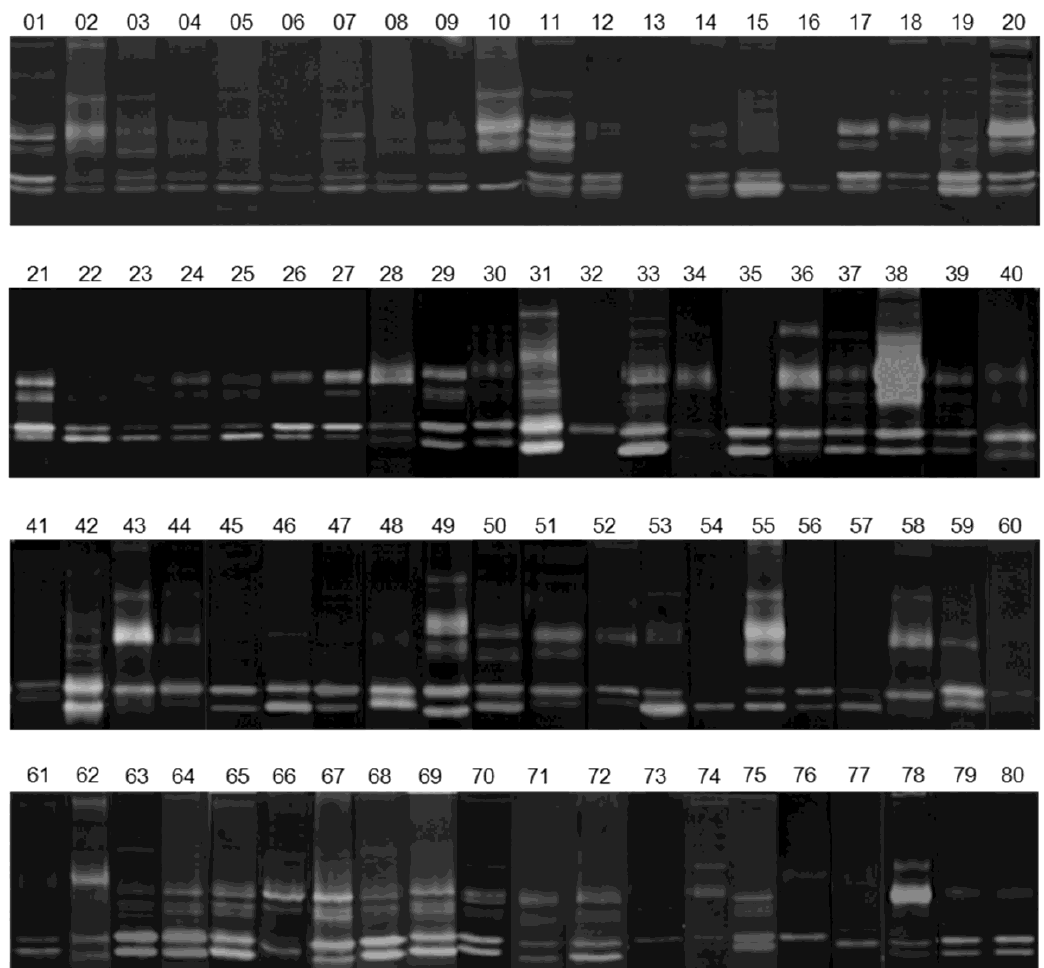
Figure 3. Gelatin zymographies of tissue extratcs from 80 breast cancer patients, showing a heterogeous level of the lytic bands. Gels were loaded with 18 ug of protein extracts and developed overnight at 37 °C, before staining with Coomassie-blue. Note the heterogeneous intensity level of the lytic bands among the patients.